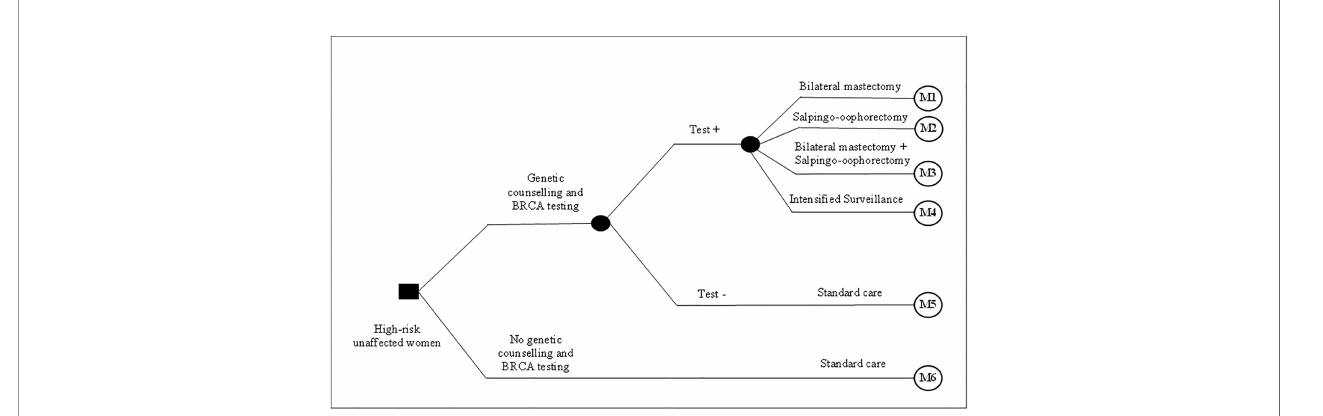
FIGURE 1 | Decision model presenting compared strategies and high-risk